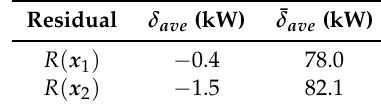
Figure 8. Average MSE as a function of the number of principal components included in the regression. Turbine T9. Table 3. Statistical behavior of the residuals between measurement and estimation, for the different random choices of the D0 and D1 data set. Turbine T9.